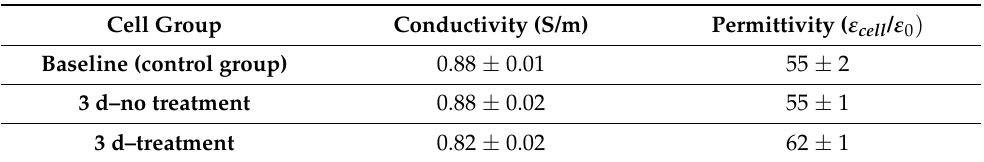
Table 5. Cytoplasmic properties obtained through the fitting procedure described in Section 2.4.1 using Equation (7), where the 3d–treatment group shows a decrease in cytoplasmic